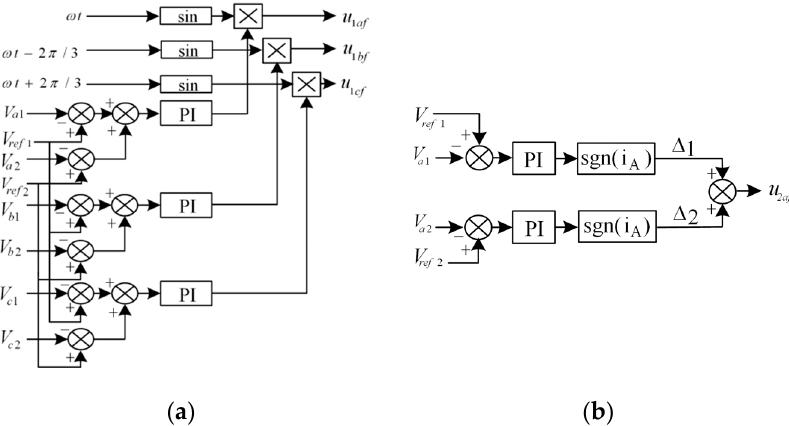
Figure 3. Control strategy of the capacitor voltage: ( a ) Overall control, ( b ) Independent control.